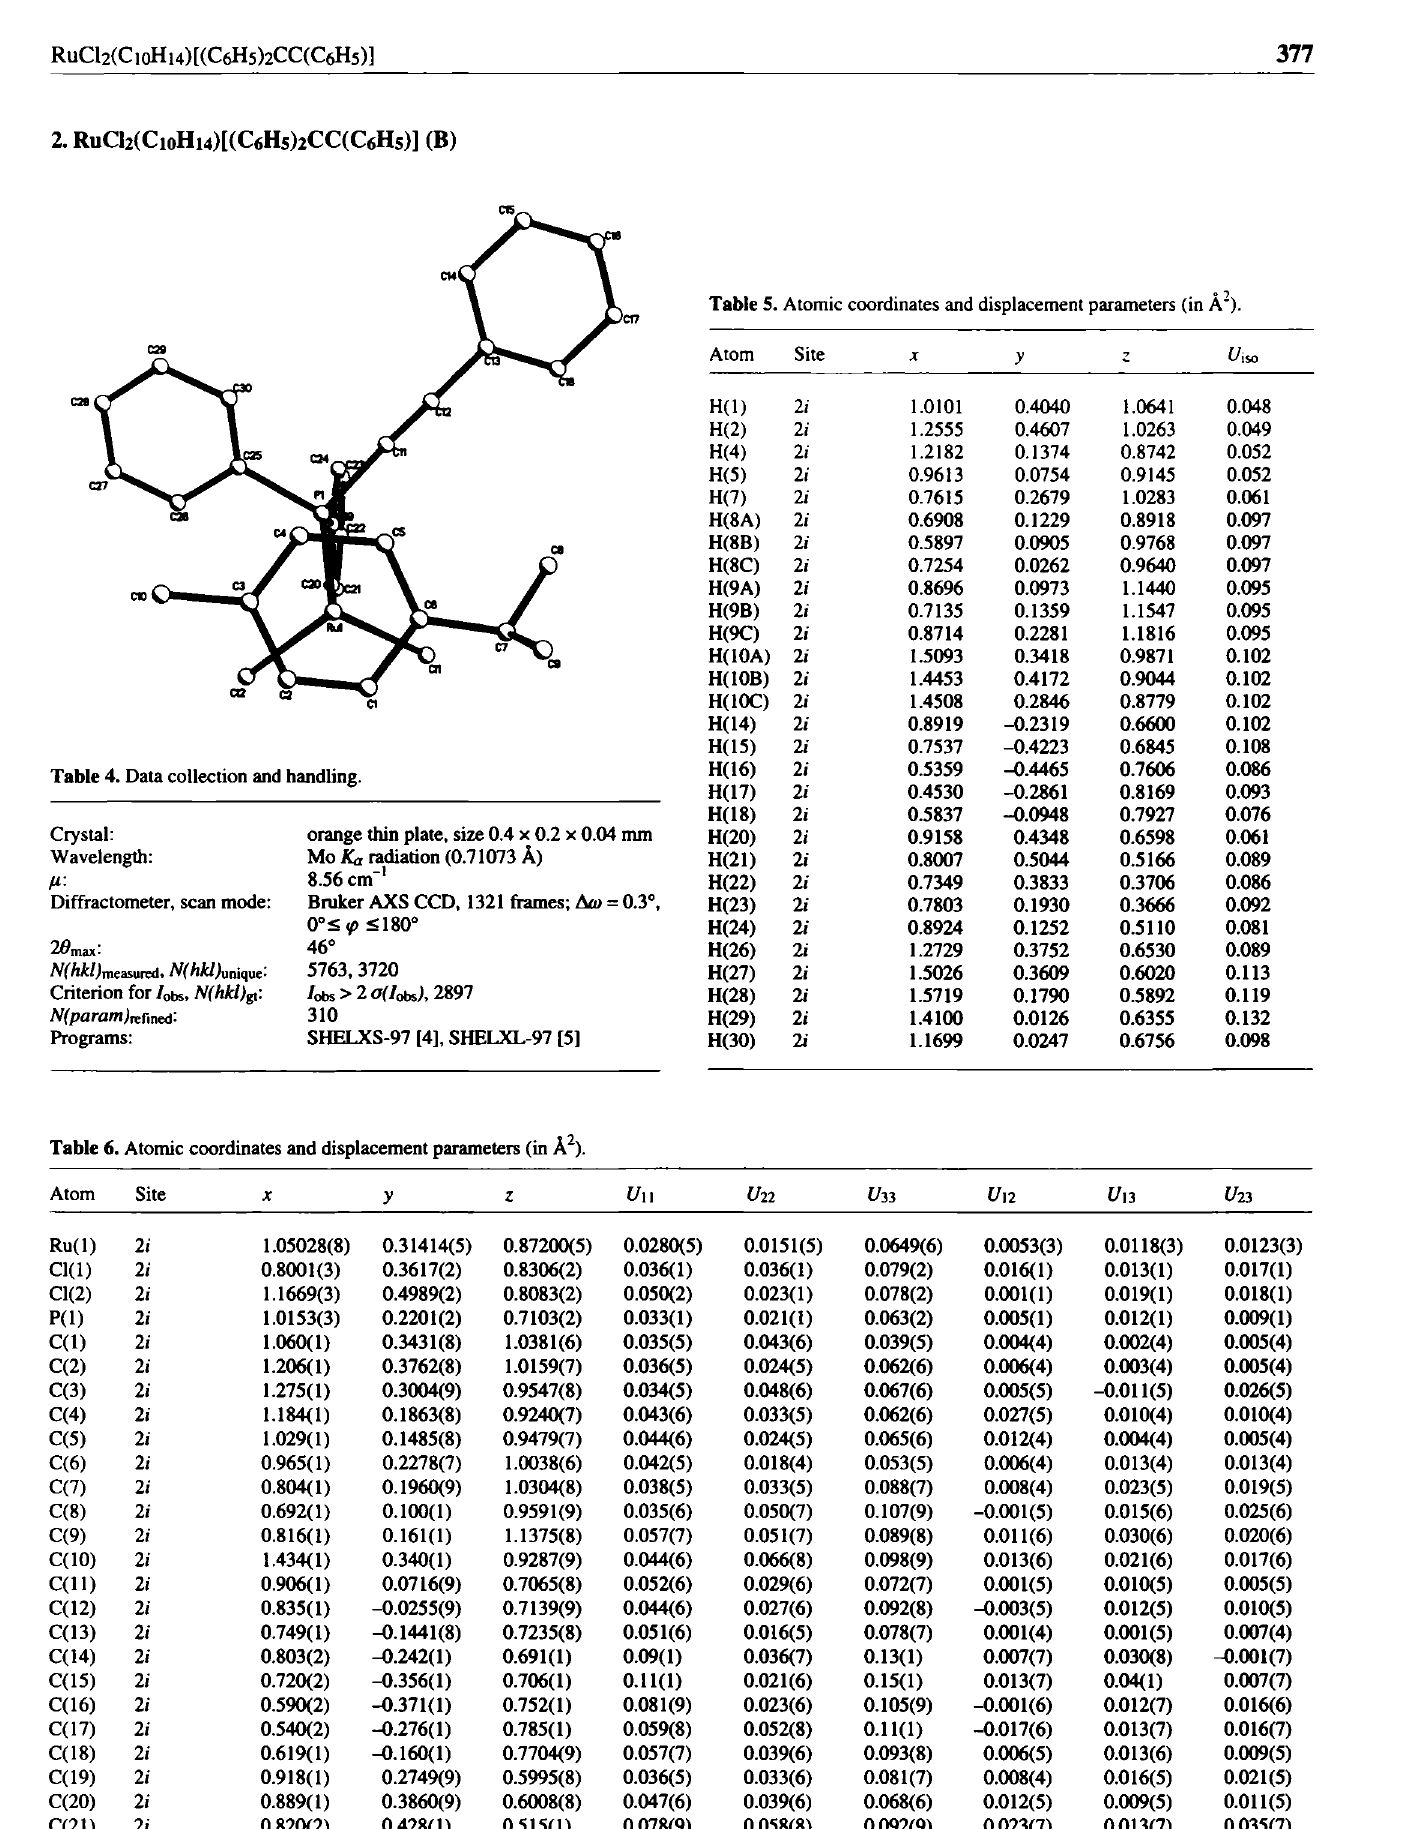
Table 6. Atomic coordinates and displacement parameters (in Â 2